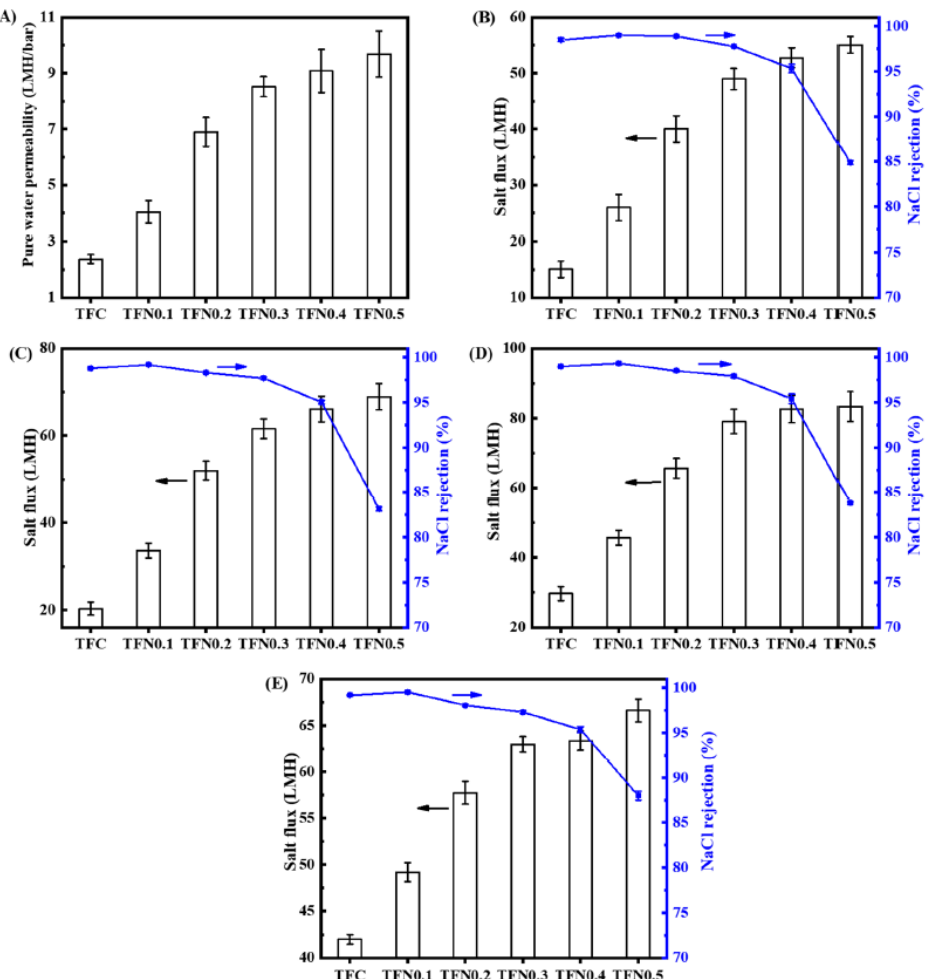
Figure 9. The membranes transport properties: ( A ) Pure water permeability coefficient; flux and rejection analysis of different NaCl concentrations and test pressures: 500 ppm and 7.0 bar ( B ); 1500 ppm and 10.0 bar ( C ); 2000 ppm and 15.5 bar ( D ); 32,000 ppm and 55.2 bar ( E